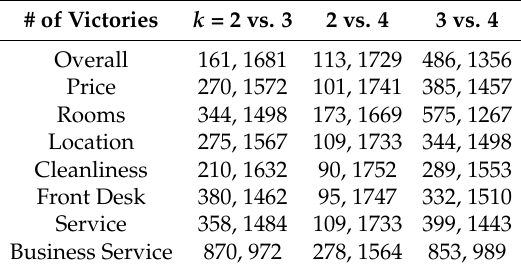
Table 16. Number of times k minimizes error with rounding.